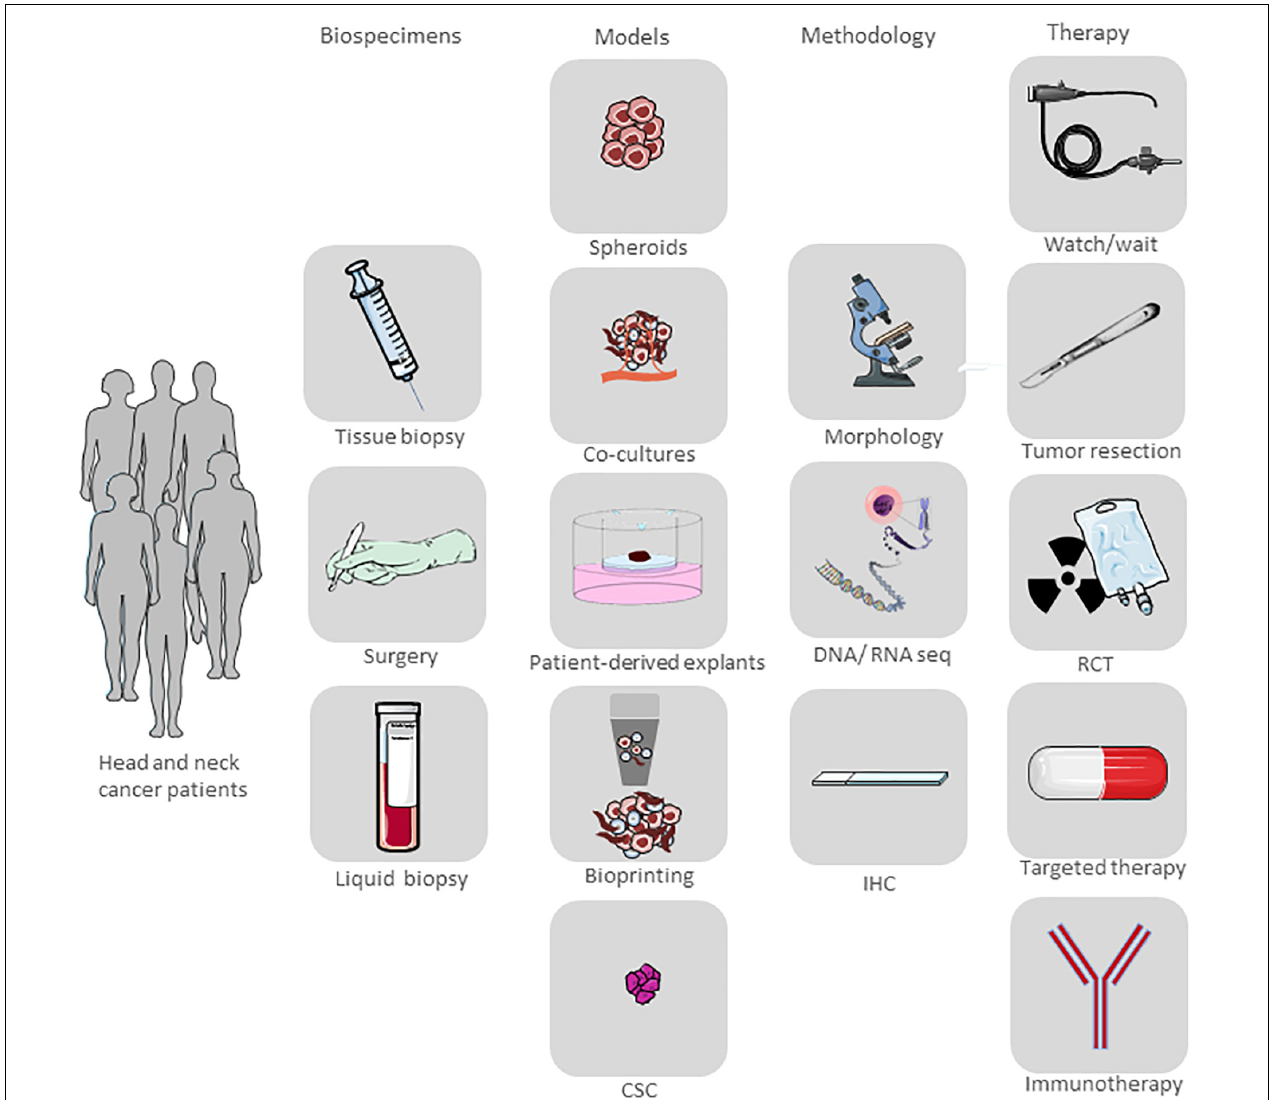
FIGURE 2 | Vision of a translational HNSCC platform. The platform ultimately aims to shorten time to diagnosis and treatment, predict tumor relapse or progress and identify targetable mutations after treatment by analysis of different biospecimen with established and new, innovative technologies. Overall, developing a precision medicine platform for head and neck malignancies will improve survival in patients with a dismal clinical outcome. Parts of the figure were drawn by using pictures from Servier Medical Art (http://smart.servier.com/), licensed under a Creative Commons Attribution 3.0 Unported License